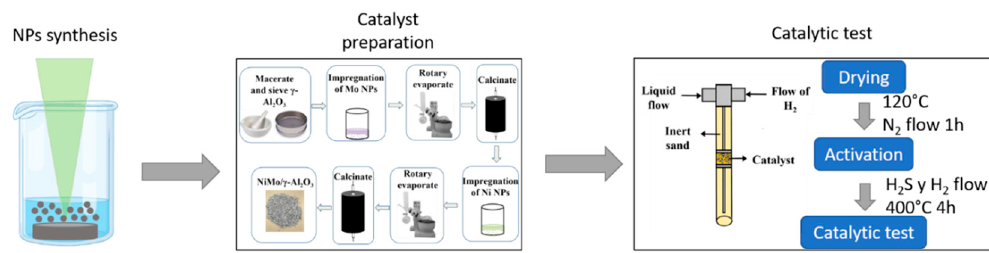
Figure 8. Experimental design.